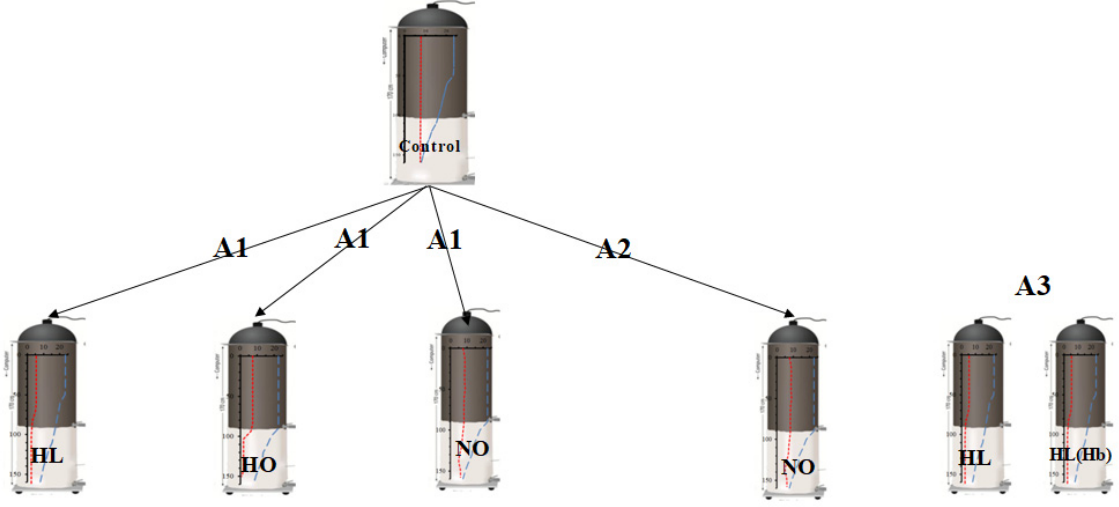
Figure 2. Diagram presenting the various experimental conditions.